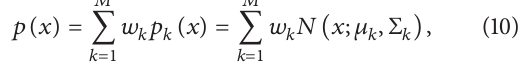
5.2. Signals and Discussion. The representative vibration sig- nal and log (𝐹(𝑠)) versus log 𝑠 map of “Normal” and “Tooth- less” gear conditions are shown in Figure 5. The detrend order is one and the minimum and maximum window sizes are 8 and 512 sample points, respectively. For captured vibration signals, Figures 5(c) and 5(d) show that there are two different scaling intervals in the double logarithmic